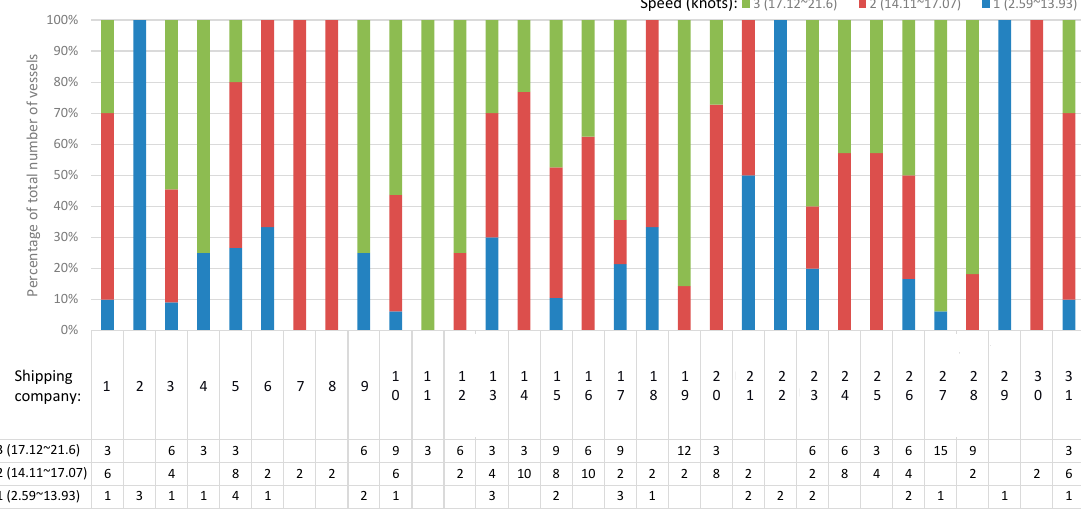
Figure 12. Speed clustering results of the 8600 TEU container ships by shipping companies.